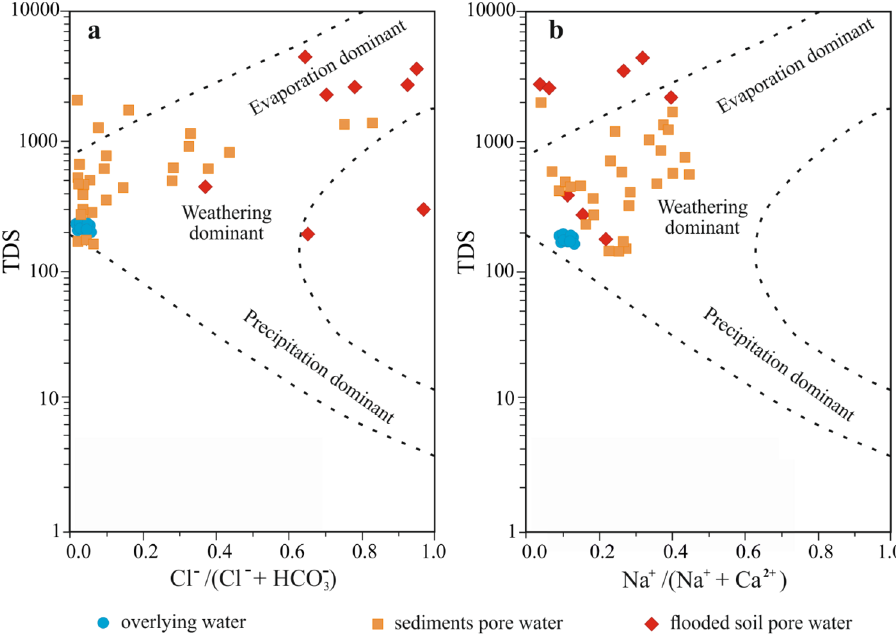
Figure 5. Gibbs diagram of overlying and pore water: ( a ) total dissolved solids (TDS) vs. equivalence ratio of Cl − /(Cl − + HCO 3 − ); ( b ) TDS vs. equivalence ratio of Na + /(Na + + Ca 2+ ). Figures were created using Grapher (17.2.435, www. golde nsoft ware. com) and CorelDRAW (21.3.0.755, www. corel.